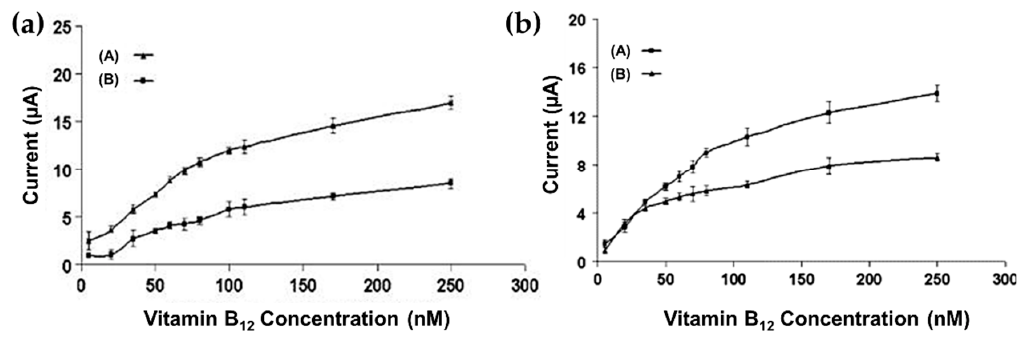
Figure 10. ( a ) Effect of vitamin B12 concentration on reduction peak currents of Co(II) to Co(I) using (A) single walled carbon nanotube (SWCNT)–chitosan modified PGE, (B) chitosan modified PGE at